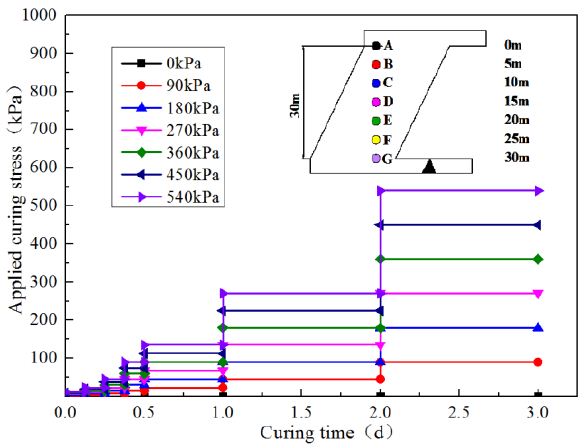
Figure 2. Schemes of the curing stress application.